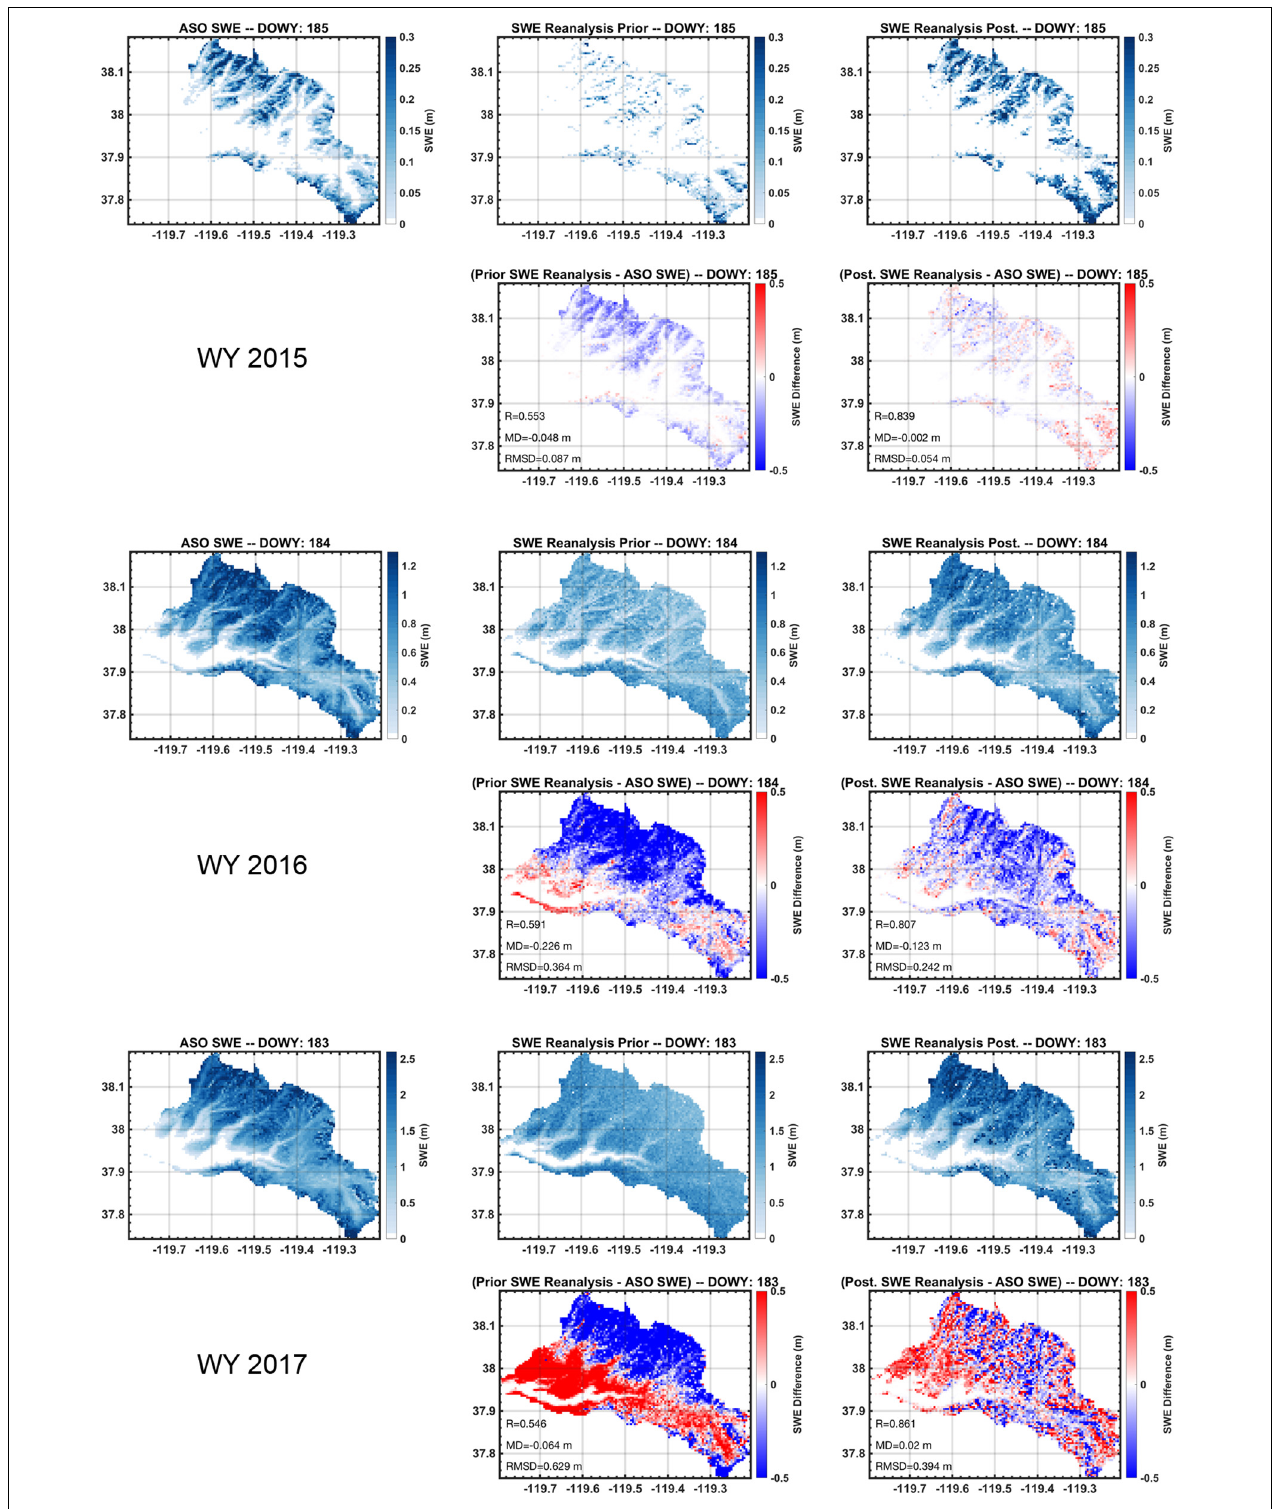
FIGURE 8 | Comparison of reanalysis results to ASO SWE estimates nearest April 1st in each verification year (WYs 2015–2017). For each WY, the ASO SWE estimates are shown in the left panel followed by the (ensemble median) prior and posterior SWE estimates. Difference fields are shown below the prior and posterior estimates to illustrate the differences relative to ASO SWE. The spatial correlation (R), mean difference (MD) and root-mean-squared difference (RMSD) relative to ASO SWE estimates are shown in the prior and posterior difference panels.